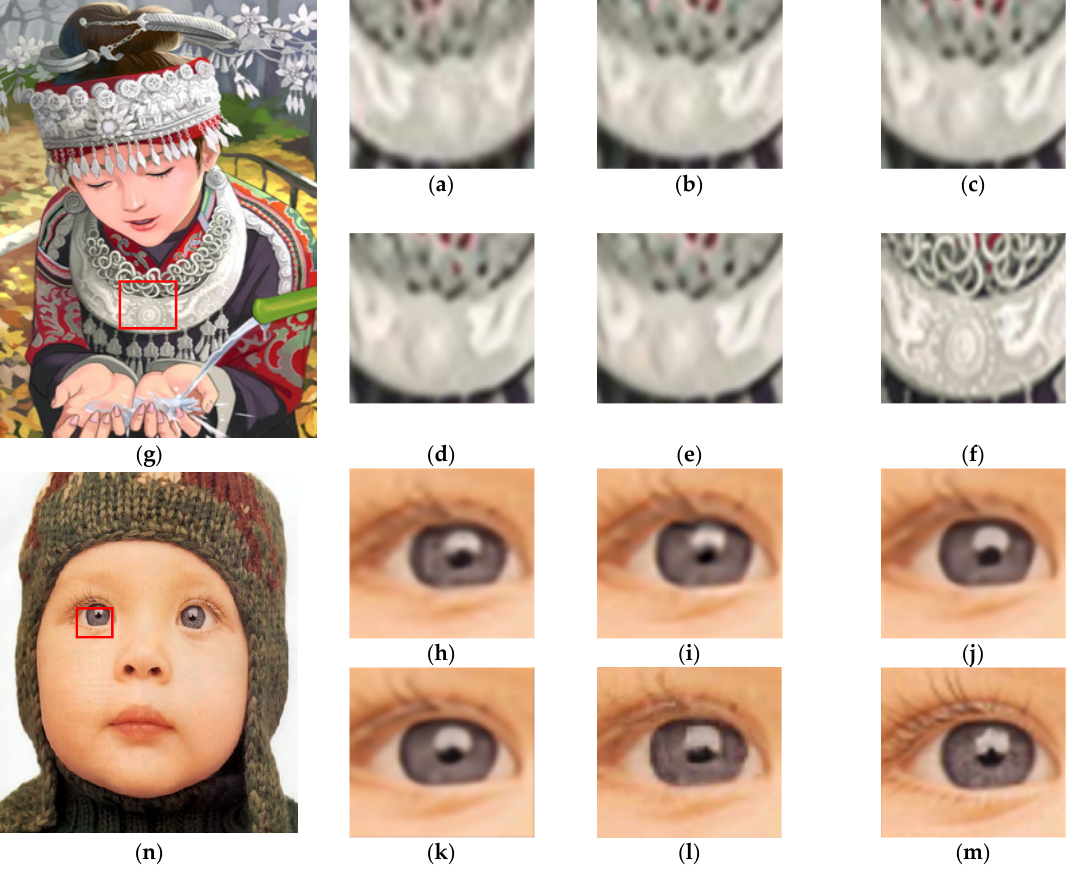
Figure 9. The visual effect of each algorithm under ×2 upscale factor. ( a ) VDSR; ( b ) Lap ‐ SRN; ( c ) Meta ‐ SR; d ) RCAN; ( e ) IDMF ‐ SR (Ours); ( f ) HR (Original); ( g ) Set14 img_005 (2×); ( h ) VDSR; ( i ) Lap ‐ SRN; ( j ) Meta ‐ SR; ( k ) RCAN; ( l ) IDMF ‐ SR (Ours); ( m ) HR (Original); ( n ) Set5 img_005 (2×).